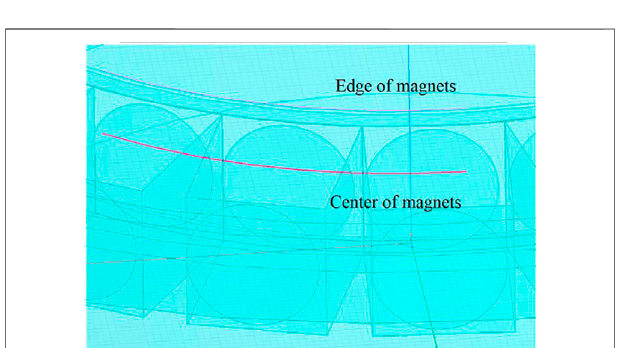
FIGURE 12 | Magnetic fi eld in the seal gap with a different type of split magnets.